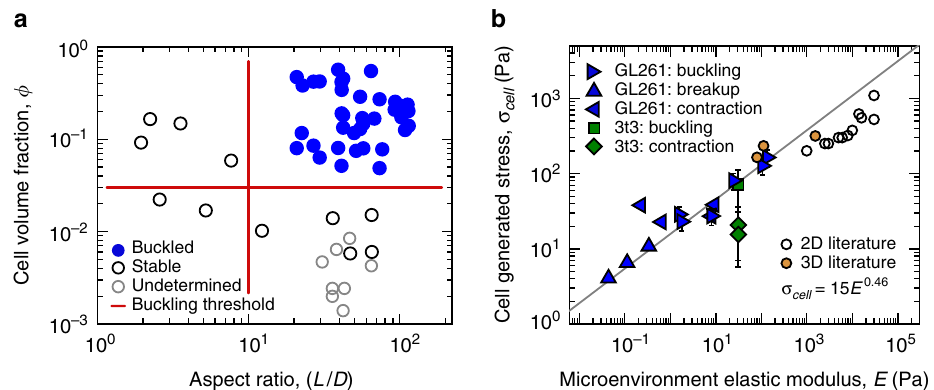
Fig. 5 Determining cell generated stress from instability thresholds and axial contraction. a We tune the average cell-generated stress within microbeams by varying cell volume fraction, ϕ , at constant collagen concentration (2 mg/mL) and microgel shear modulus (0.46 Pa). Beams with ϕ < 0.03 do not buckle; data from sparse beams are marked undetermined as buckling is not observed but dif fi cult to rule-out. Low aspect ratio beams ( L / D < 10) remain straight. (separate measurements displayed: n = 36 buckled, n = 11 stable, and n = 8 undetermined data points.) b We estimate the average stress generated by single cells, σ cell , in beams that buckle, break-up, and contract. Most data points follow a scaling law relating σ cell to E that nearly extrapolates to 2D and 3D traction force microscopy data. Error bars correspond to ±standard deviation of repeated measurements. (separate measurements displayed: n = 5 GL261 buckling, n = 3 GL261 breakup, n = 4 GL261 contraction, n = 1 3t3 buckling, n = 2 3t3 contraction; literature data: n = 11 2D, and n = 3